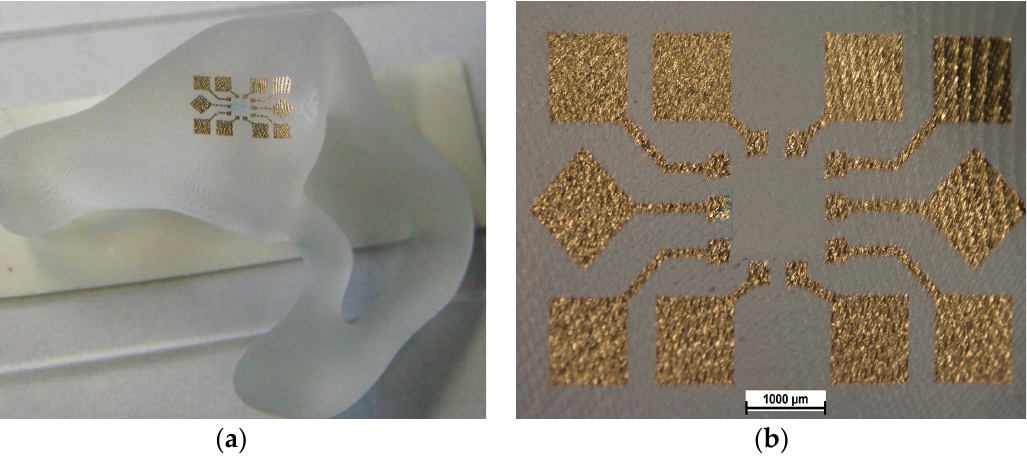
Figure 4. Aerosol jet printed Ag structures (ink: Sicrys I30 EG-1) on 3D ear mold substrate (Luxaprint 3D mold) after photonic curing ( a ). Landing pads for pressure sensor in detail ( b ).